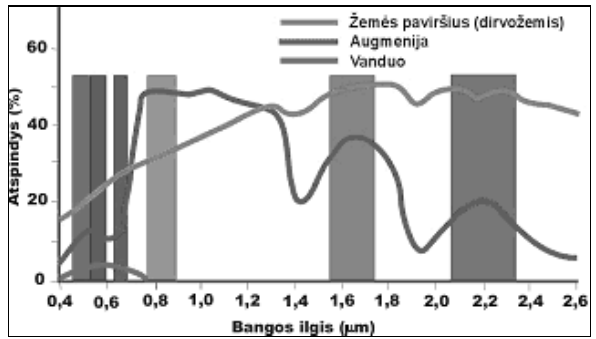
Fig 3 . Vegetation, soil and water typical reflection and TM,